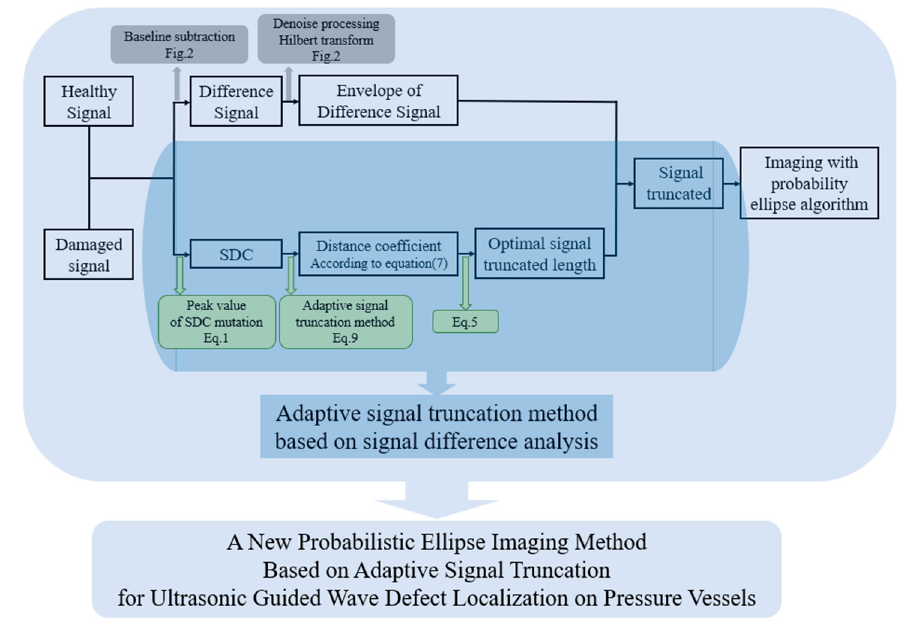
Figure 10. Adaptive signal truncation method based on signal difference analysis.